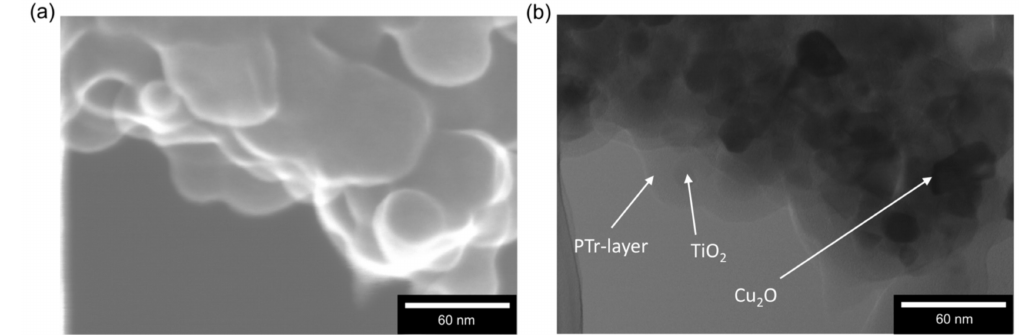
Figure 5. STEM images of Cu 2 O/PTr–TiO 2 sample in SEM ( a ) and TEM ( b )